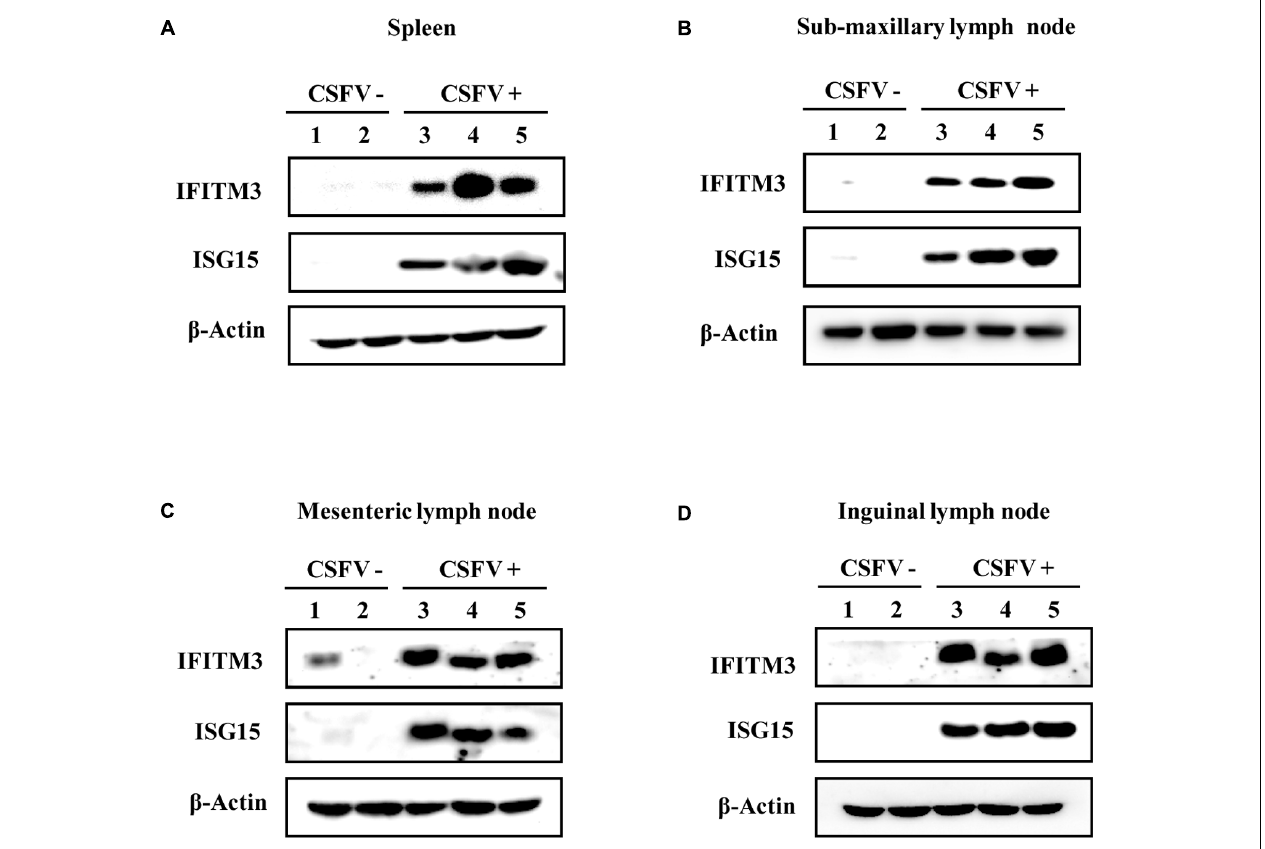
FIGURE 6 | Protein expression of IFITM3 and ISG15 in pigs is up-regulated by CSFV infection. (A–D) Pigs were infected with CSFV (numbers 3, 4, and 5) or mock treatment (numbers 1 and 2) for 5 days, followed by Western blotting using indicated antibodies. Shown is the expression of IFITM3 and ISG15 in (A) spleen, (B) sub-maxillary node, (C) mesenteric lymph node, and (D) inguinal lymph node. Shown are representative of three independent experiments with similar